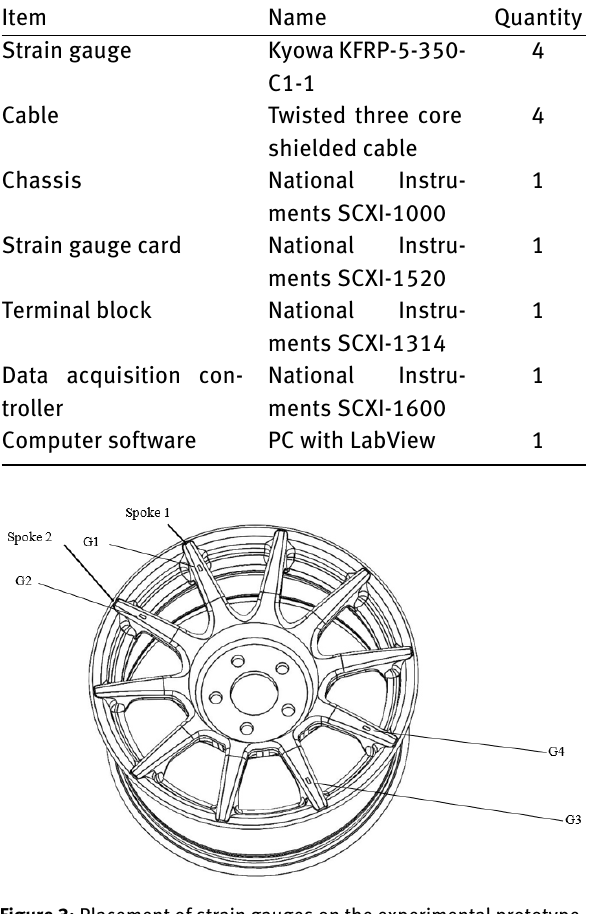
The experimental prototype was instrumented with 4 Kyowa KFRP-5-350-C1-1 strain gauges that were placed on the outer surface of the wheel on the spokes. Figure 3